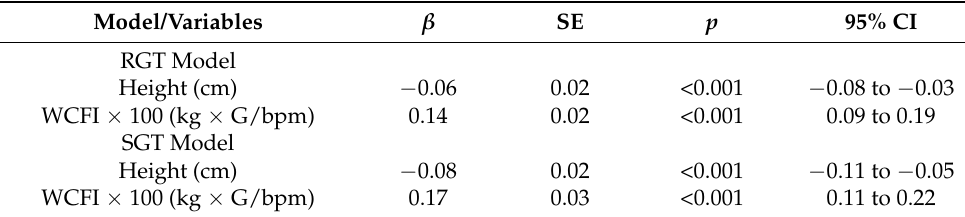
Table 3. Variables associated with G tolerance analyzed by multivariate linear regression.